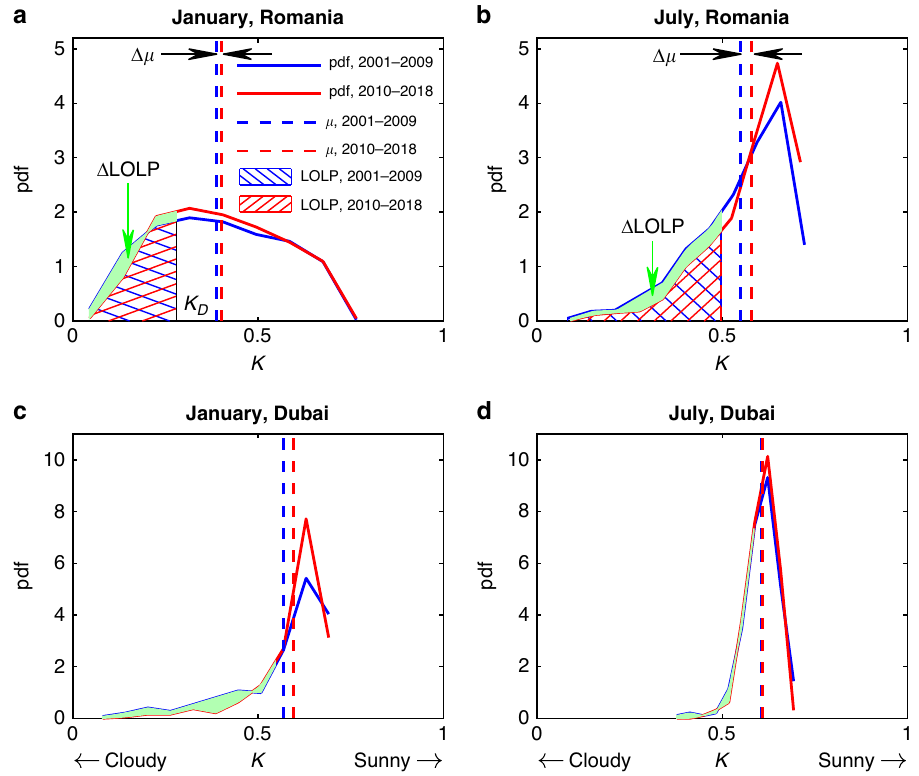
Fig. 1 Examples of climate impacts on solar radiation and photovoltaic power reliability. The distribution of clearness index ( K ) derived from the CERES data in ( a , c ) January and ( b , d ) July during 2001 – 2009 (blue lines) and during 2010 – 2018 (red lines) in ( a , b ) Southern Romania and ( c, d ) Dubai. The hatched areas indicate the probability when power generation does not meet the demand, the loss-of-load probability (LOLP). The averages of clearness index are marked by the vertical dash lines and the values are reported in Supplementary Table 1. Source data are provided as a Source Data fi